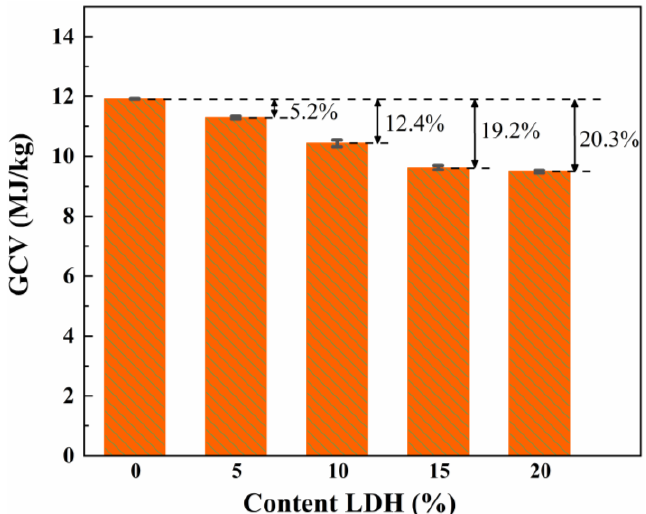
Figure 12. GCV of the pure SA and LDH/SA with various MgAl-LDH additive content.